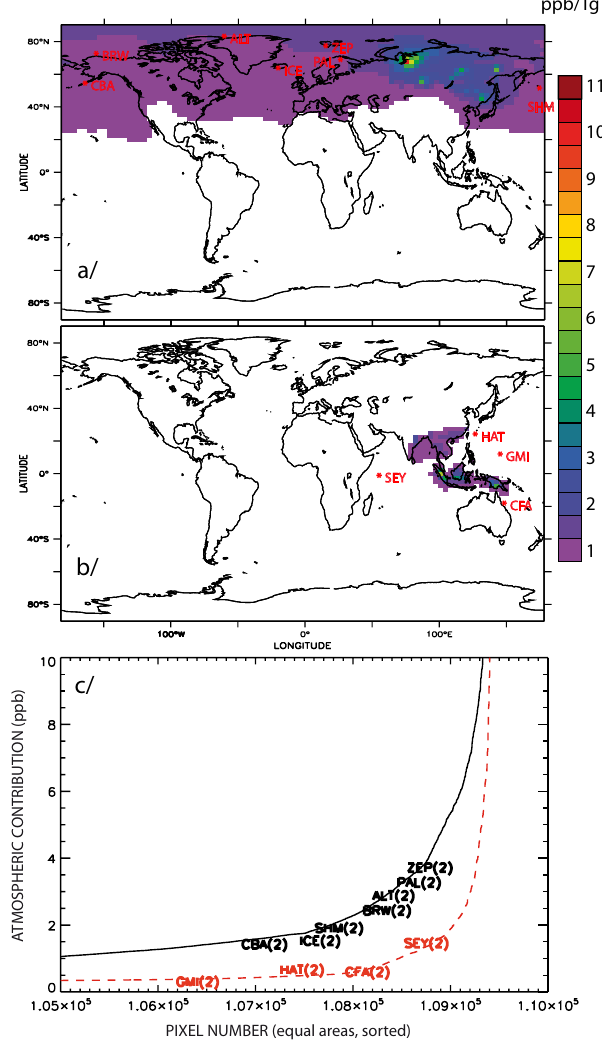
Fig. 3. Impact at the surface of a 1TgCH 4 pulse emitted from two regions (see text): boreal Asia and tropical Asia. (a) Mean plume for Boreal Asia, computed as the mean of the 12 monthly plumes gen- erated by 1 month of emission followed by 11 months of transport without emission (in ppbTg − 1 CH 4 ) ; (b) same as (a) for tropical Asia. (c) Maximum increase in mixing ratio detected for all trans- port model pixels, at the surface, for emissions in boreal Asia (black solid line) or in tropical Asia (red dashed line). Model pixels have the same surface in order to normalize the comparison between a boreal and a tropical region. Model pixels are sorted by increasing values for each emitting region. Only pixels with the largest mix- ing ratios are kept for the plot. Maximum values at model pixels containing atmospheric measurement stations used in the inversion are plotted above the lines, as the name of the stations. The month when the maximum is reached is plotted as a number in parentheses. Locations of the stations are shown in (a) and (b)